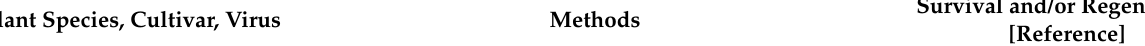
Plant Species, Cultivar, Virus Methods